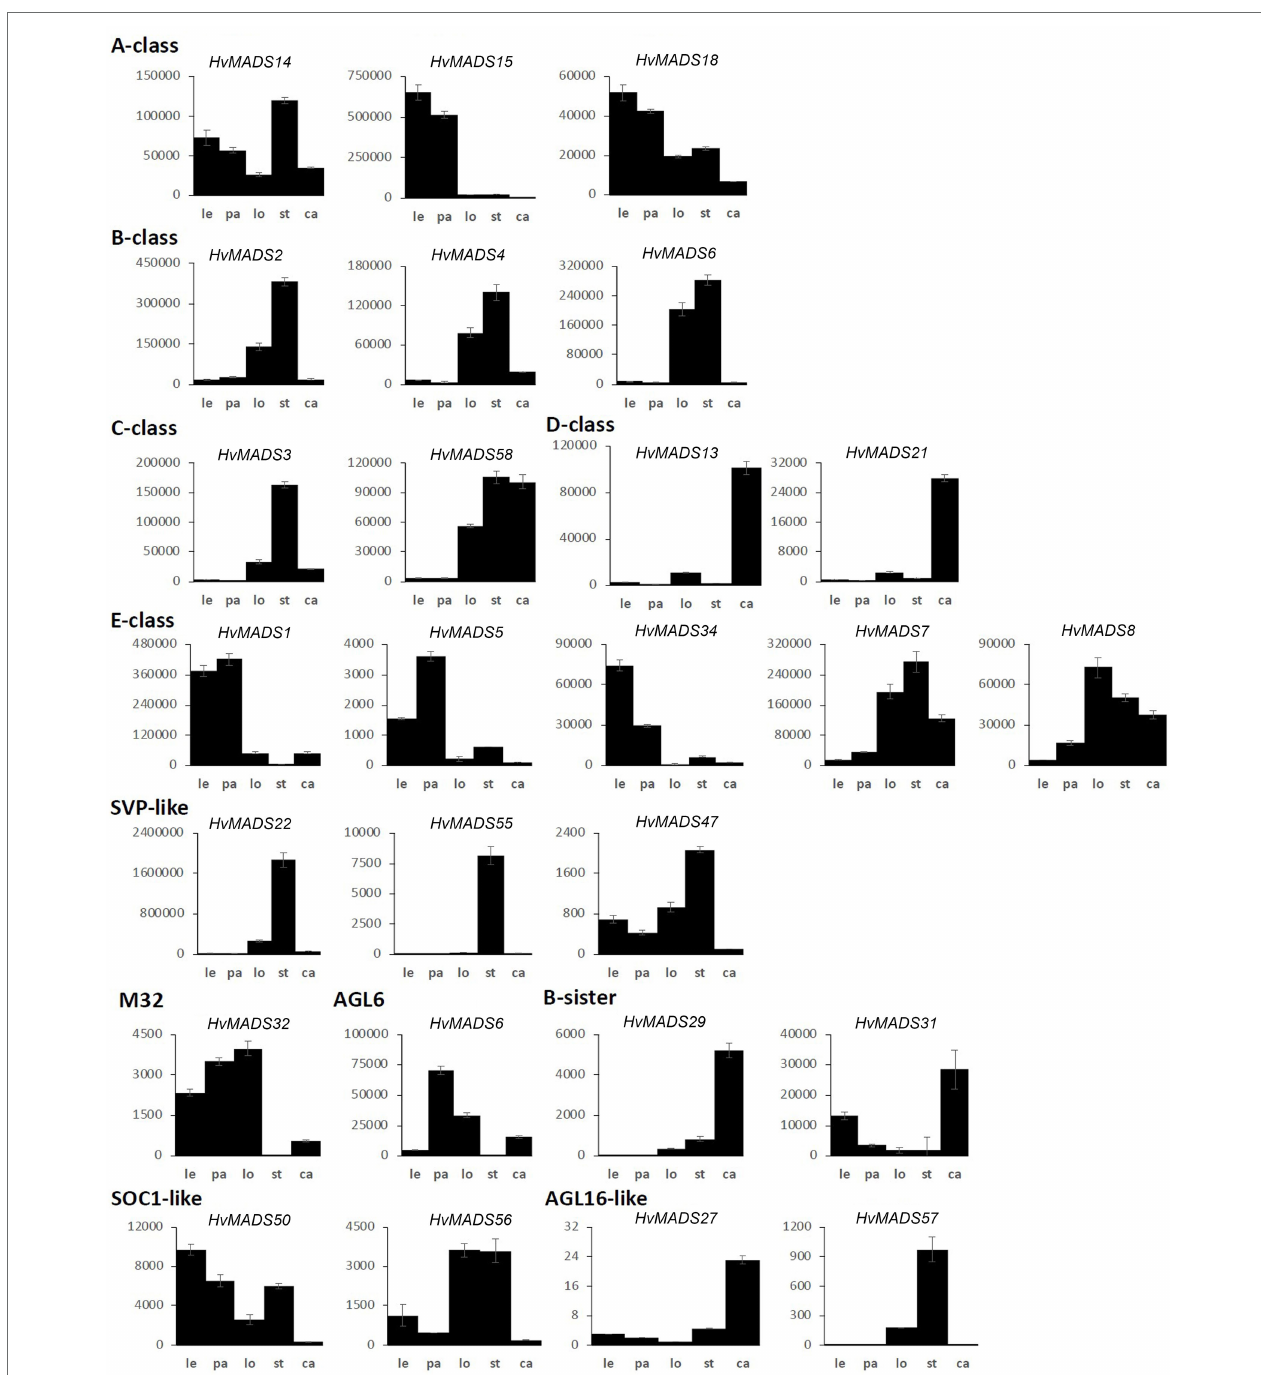
FIGURE 5 | MIKCc MADS-box gene expression in floral organs at Waddington stage 9.5. Error bars represent one standard deviation, based on technical replicates. Le, lemma; pa, palea; lo, lodicules; st, stamens; and ca,